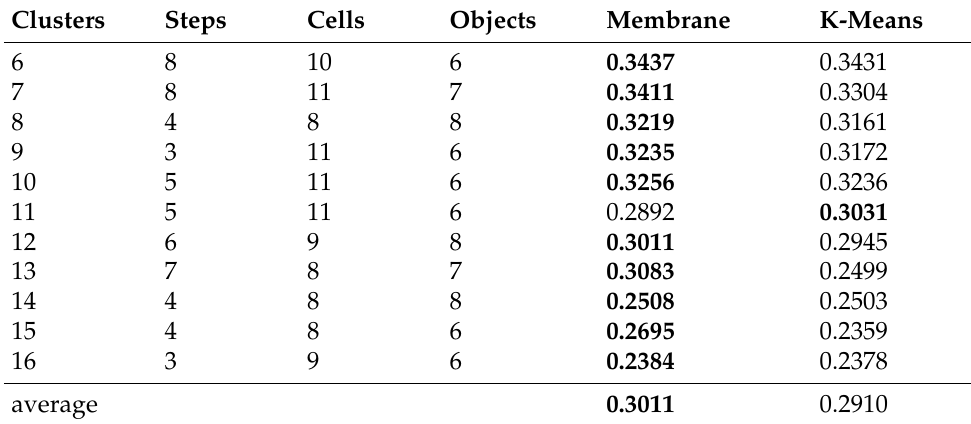
Table 7. Silhouette scores of the K-Means and the membrane clustering with the different number of clusters and m-gram size of 11 and using different membrane configurations. The Better scores are bold in the table.